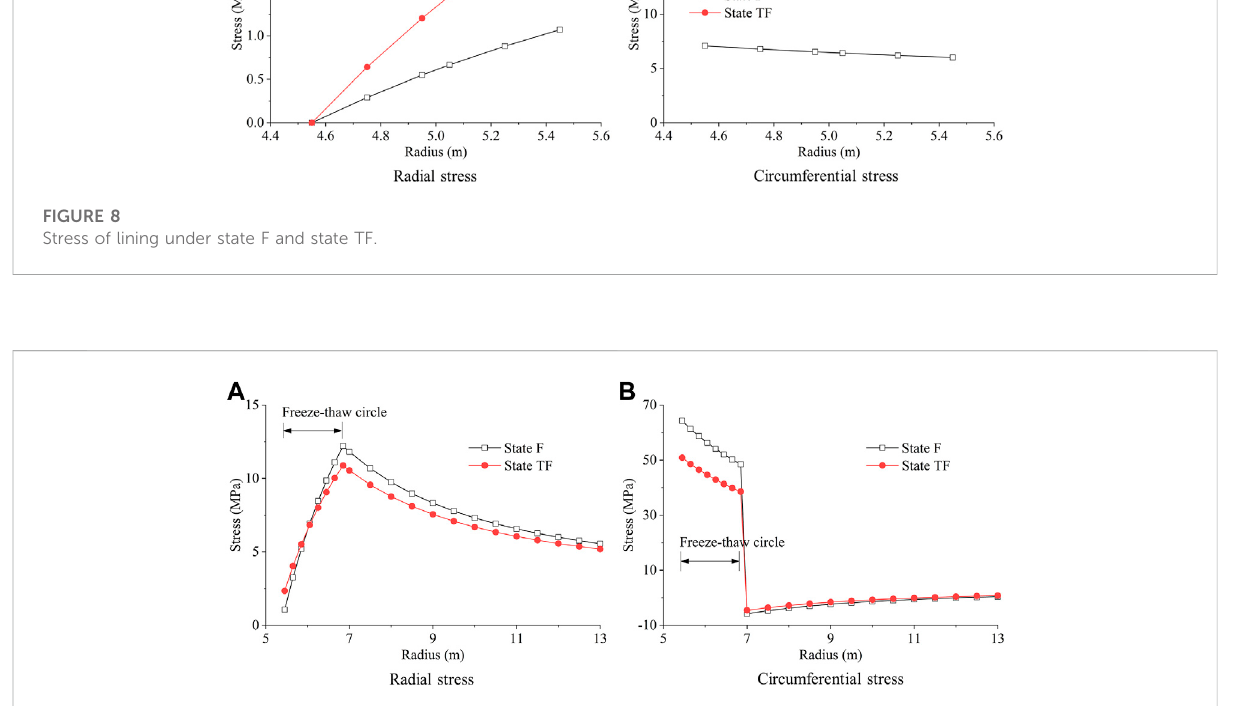
FIGURE 9 Stress of surrounding rock under state F and state